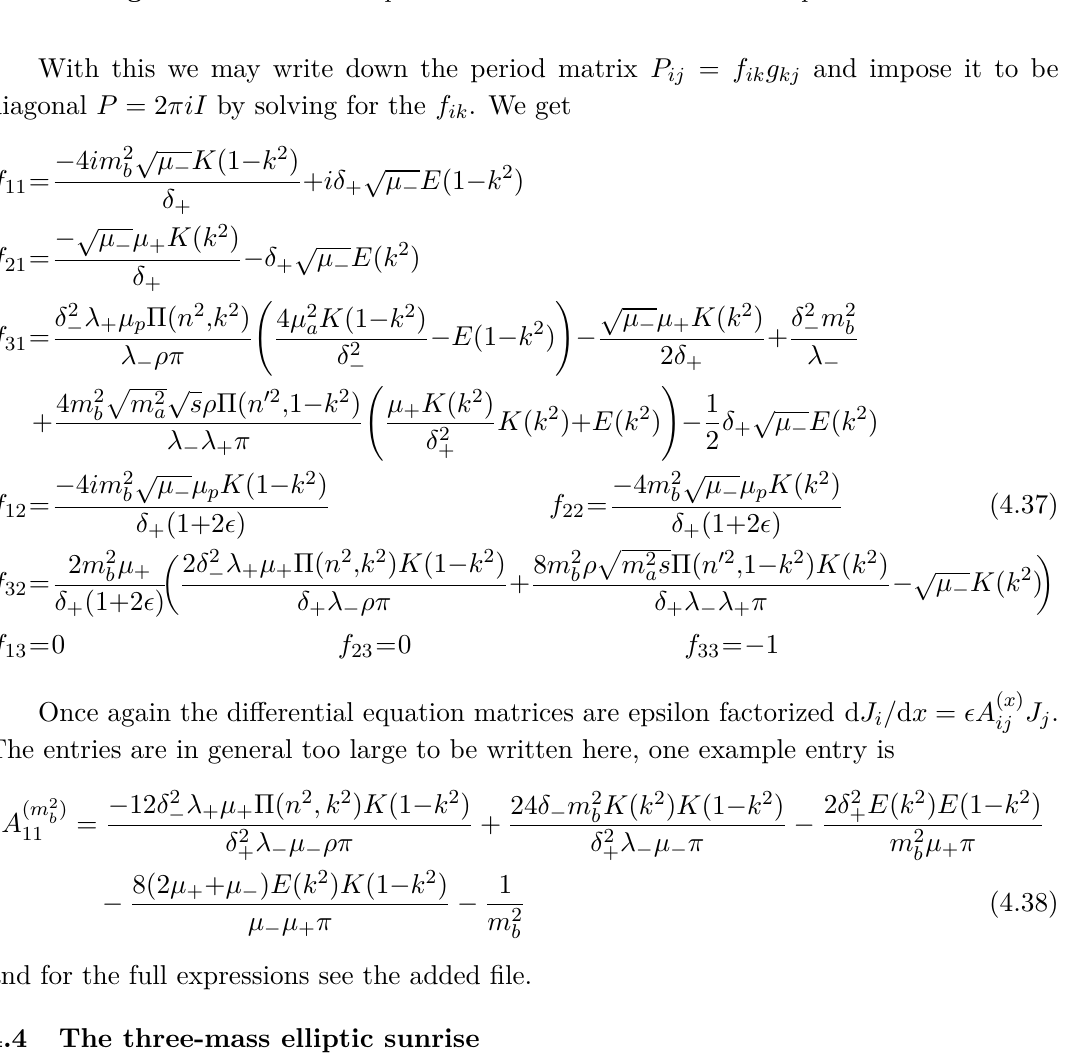
Figure 6 . The three independent contours for the two-mass elliptic